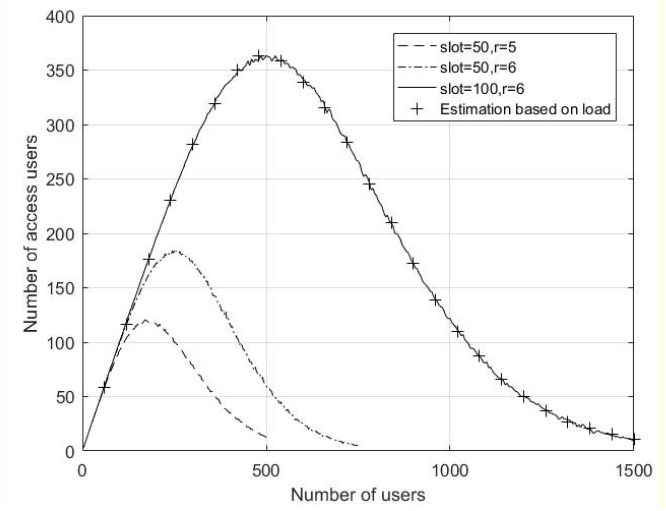
Figure 13. Throughput performance simulation curve of the improved protocol.